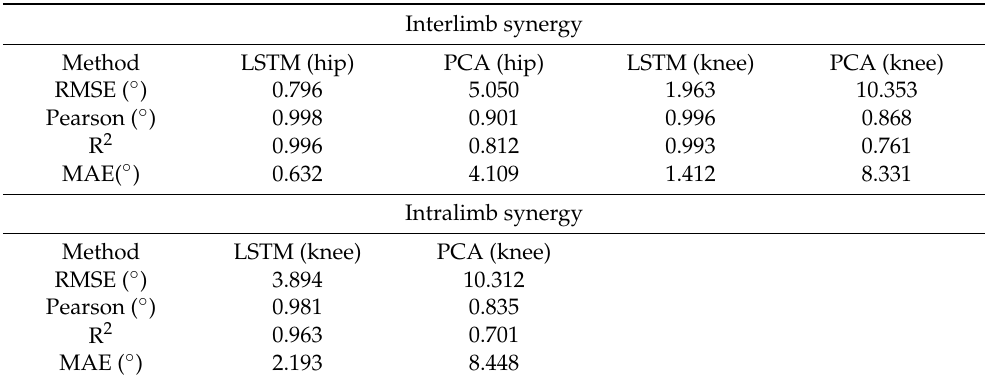
Table 4. Experimental results of LSTM and PCA based on interlimb and intralimb